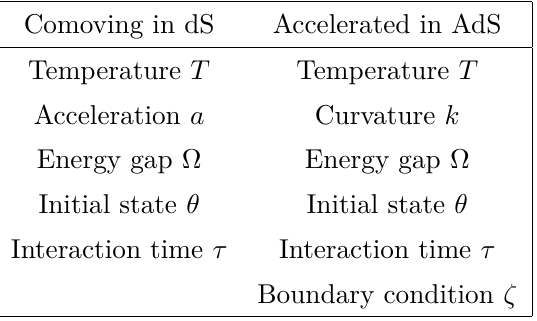
Table 1 . List of relevant parameters for temperature estimation in dS 4 and AdS 4 . Acceleration a and curvature k = 1 /‘ play analogous roles, as explained below. AdS 4 has the chosen boundary condition (see (2.27)) as an extra